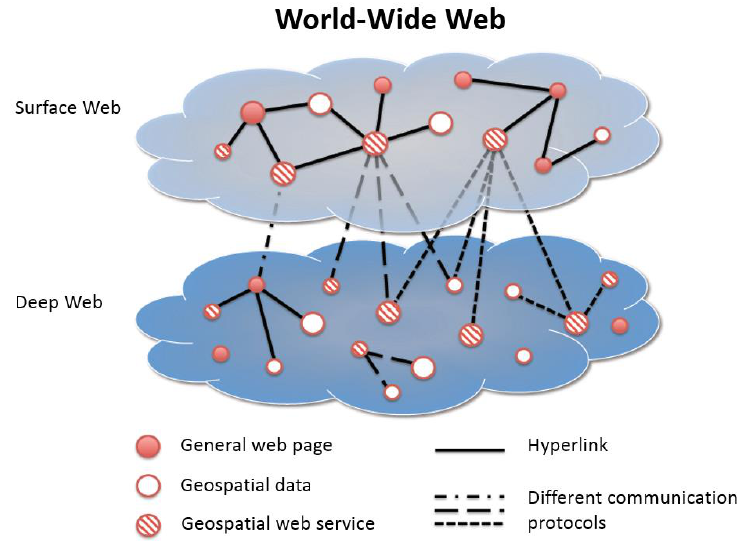
Figure 3. The concept of the Surface Web and the Deep Web.